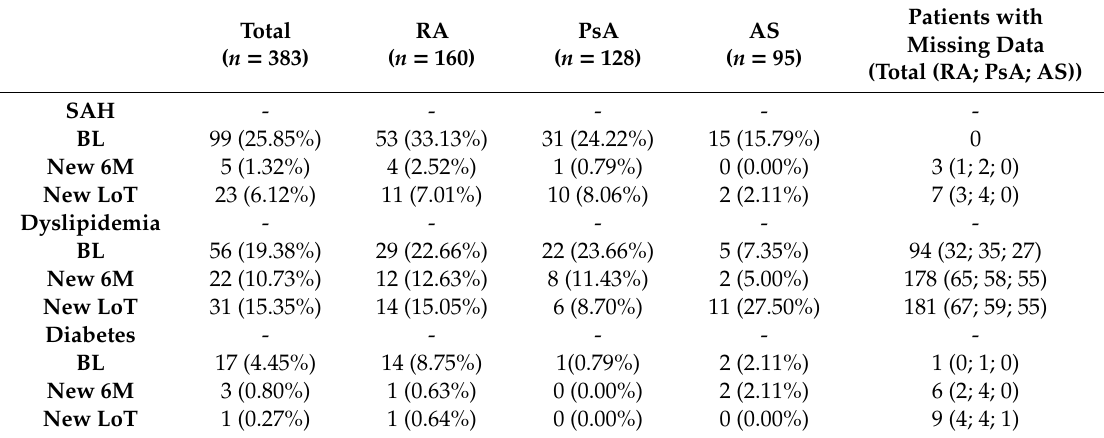
Table 3. Distribution of comorbidities in the study population at baseline (BL) and new cases of comorbidities at six months (6M) and last visit